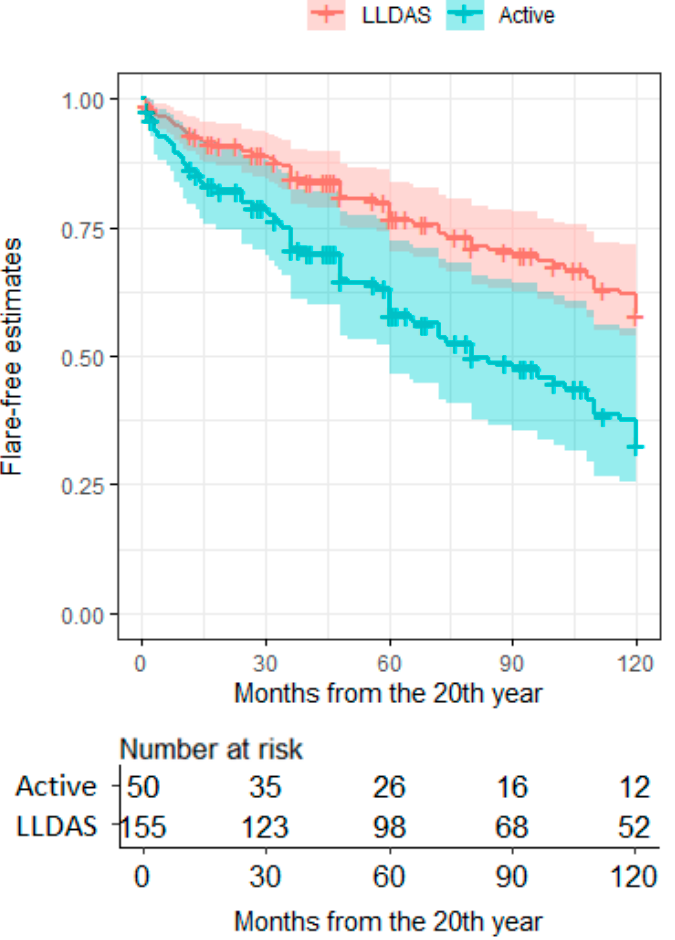
Figure 2. Ten-year flare-free estimates in long-term SLE patients according to the LLDAS status at 20 years. Flare-free survival estimates after the 20th year of disease according to the activity state at the 20th year. LLDAS, lupus low-disease-activity state; Active, absence of LLDAS (active disease). Late flares (that is, occurring after 20 years of follow up, N = 52/88, 59%) were more frequent among patients with progressing SLICC/ACR-DI (N = 52/88, 59.0%) than among patients who did not accrue additional damage after 20 years of follow up (N = 41/128, 32.0%; OR = 3.411, CI95 = 1.90–6.12, p = 2.7 × 10 − 5